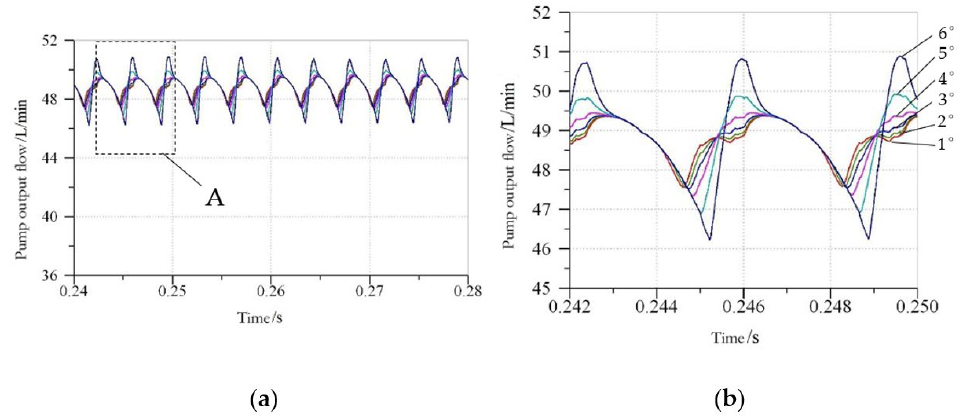
Figure 18. Actual output flow rate of piston pump with 11 pistons for ∆ ϕ /2 = ϕ 0 = 1~6 ◦ . ( a ) Pump output flow; ( b ) Pump output flow (enlarged view at A).